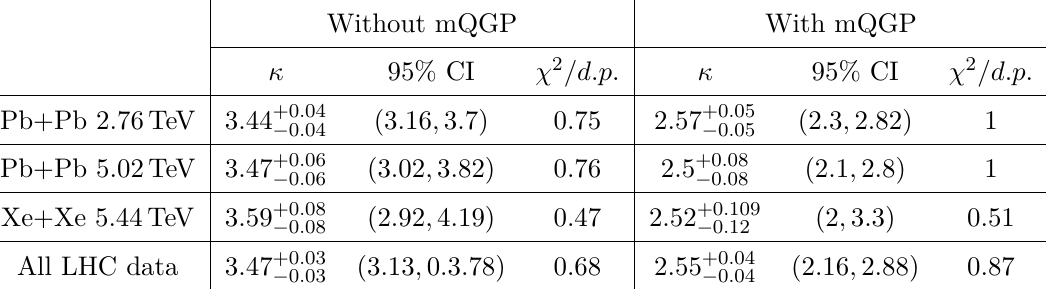
Table 1 . Optimal values of κ with 1 σ standard errors, 95% CI and corresponding χ 2 /d.p. , obtained for k = 2 , c = 0 . 8 at τ 0 = 0 . 5 fm, τ max = 1 . 05 × ( dN ch /dη ) 1 / 3 for 10 < p T < 120 GeV for different energies/processes separately and for all LHC data for scenarios without (left) and with (right) mQGP formation in pp collisions.